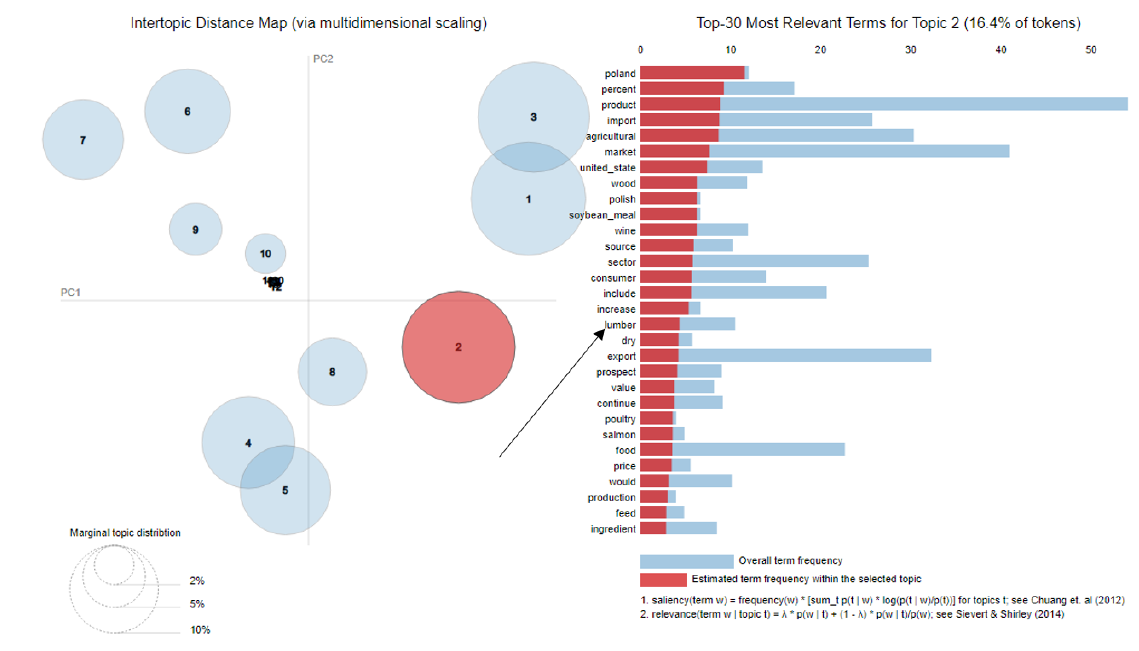
Figure 2. Lumber: Topic 2.